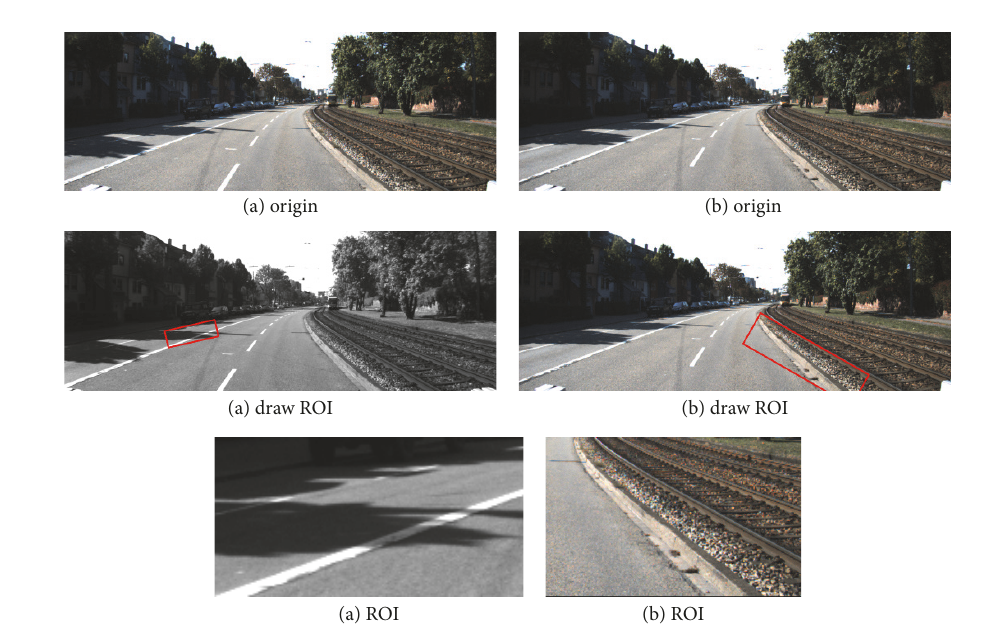
Figure 17: ROI selection of white of the sample frames (a) and (b).